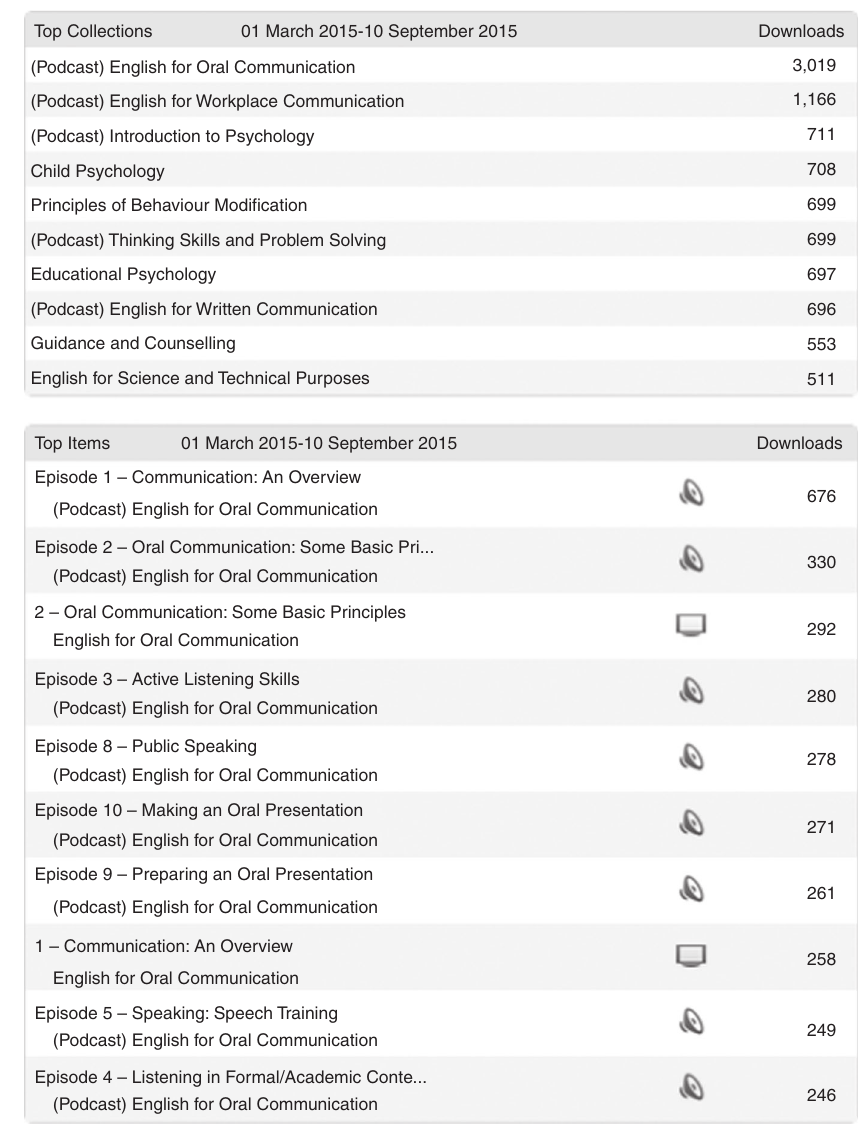
Figure 8. Download statistics from OUM iTunes